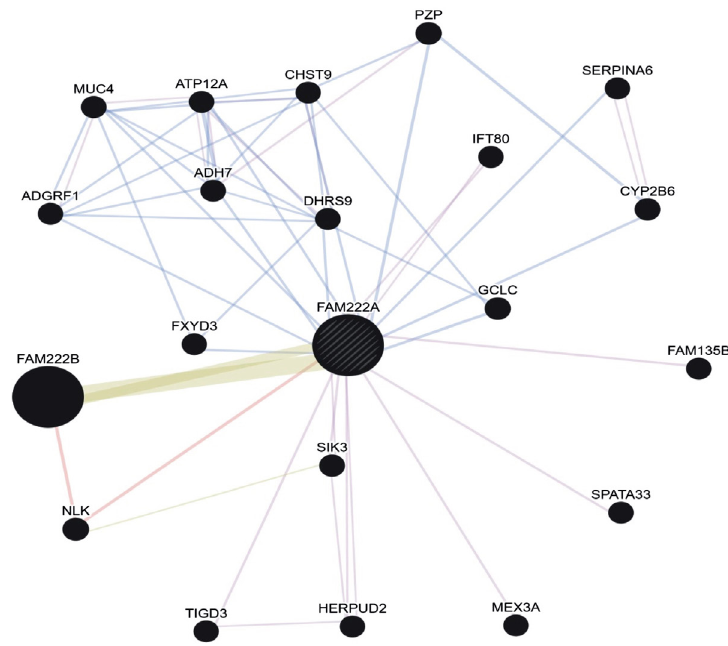
Figure 3 . GeneMANIA found functionally similar genes using a wealth of genomics and proteomics data of FAM222A related genes. According to this network, between FAM222A and FAM222B have shared protein domains, and sequence similarities (0.59%) concerning INTERPRO and